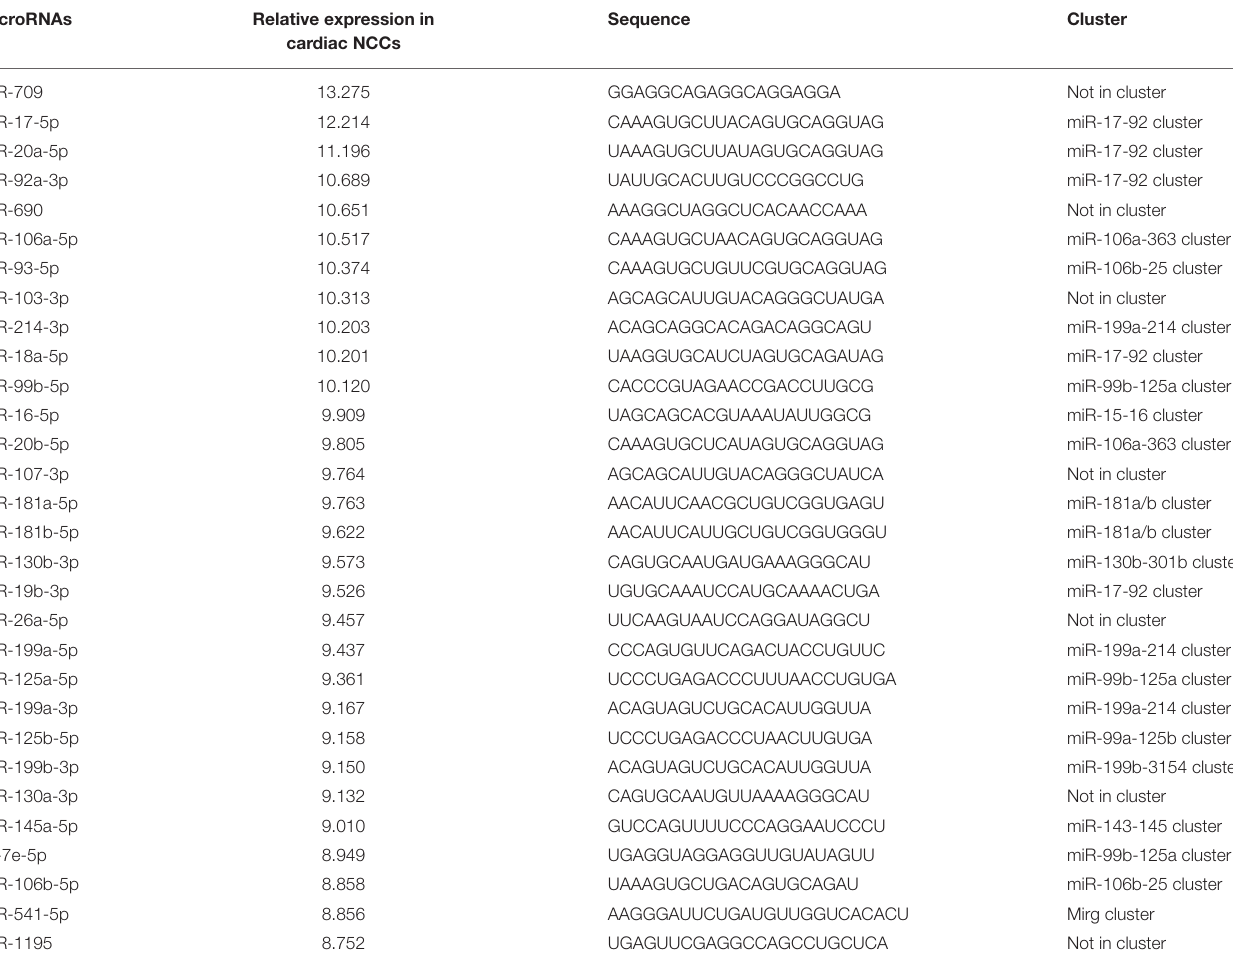
TABLE 1 | Top 30 most abundant miRNAs in cardiac